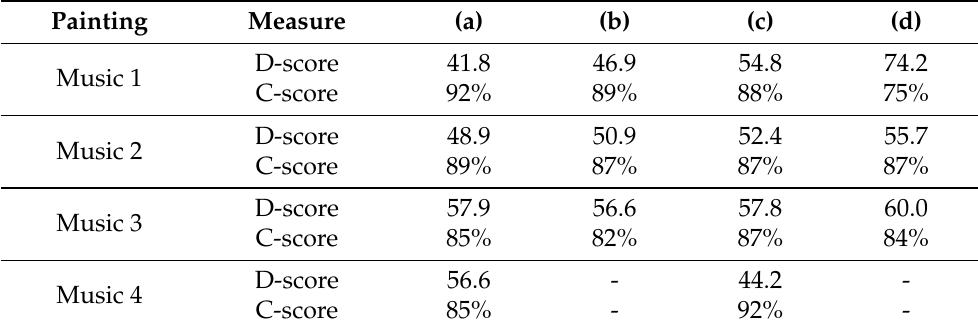
Table 7. Results of the implicit multi-sensory concordance experiments. The D-score is the Euclidean distance and the C-score is the cosine similarity.